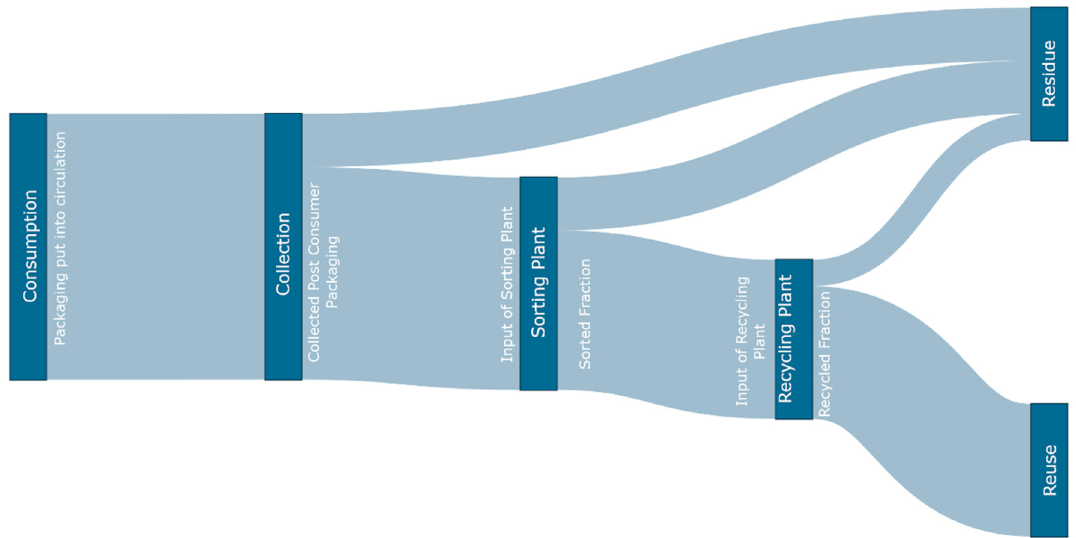
Figure 1. Sankey diagram laying out the different inputs and outputs of the recycling system.